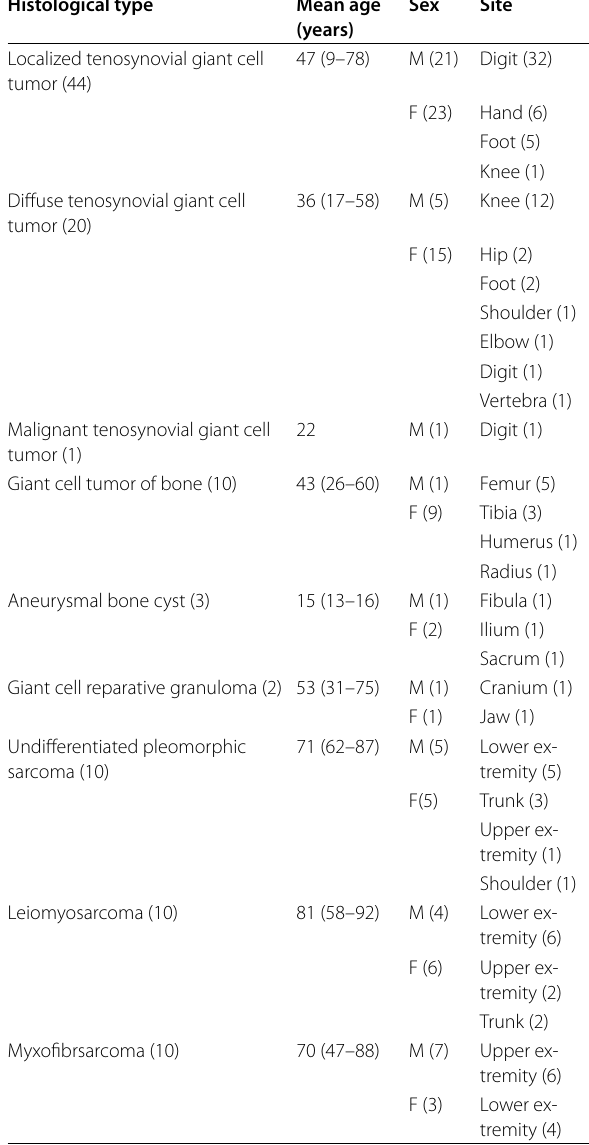
Table 1 Clinical findings of the 110 cases examined Histological